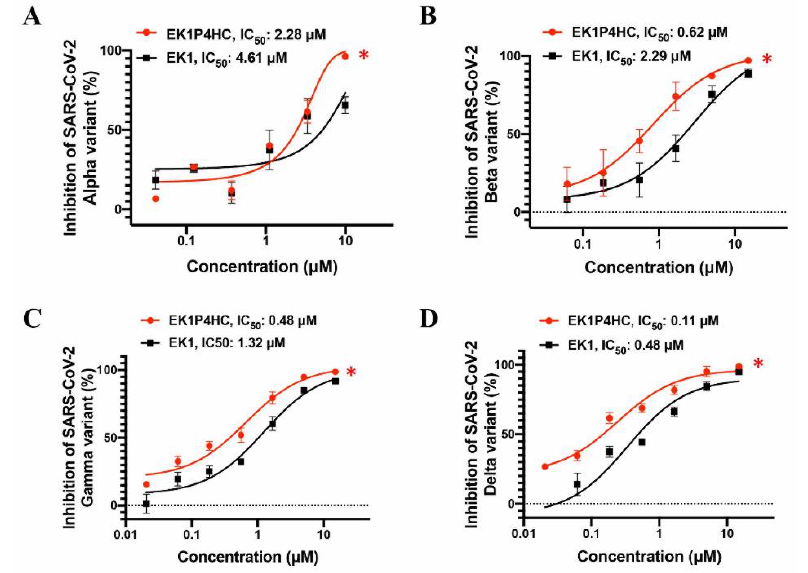
Figure 4. EK1P4HC could potently inhibit the infections by SARS-CoV-2 VOCs. Inhibitory activity of EK1P4HC against SARS-CoV-2 VOCs, including Alpha ( A ), Beta ( B ), Gamma ( C ), and Delta ( D ) variants. Each peptide was tested in triplicate, and experiments were repeated twice. Statistical differences were analyzed at concentrations of 1.66 µ M or 10 µ M of peptides, *, p <